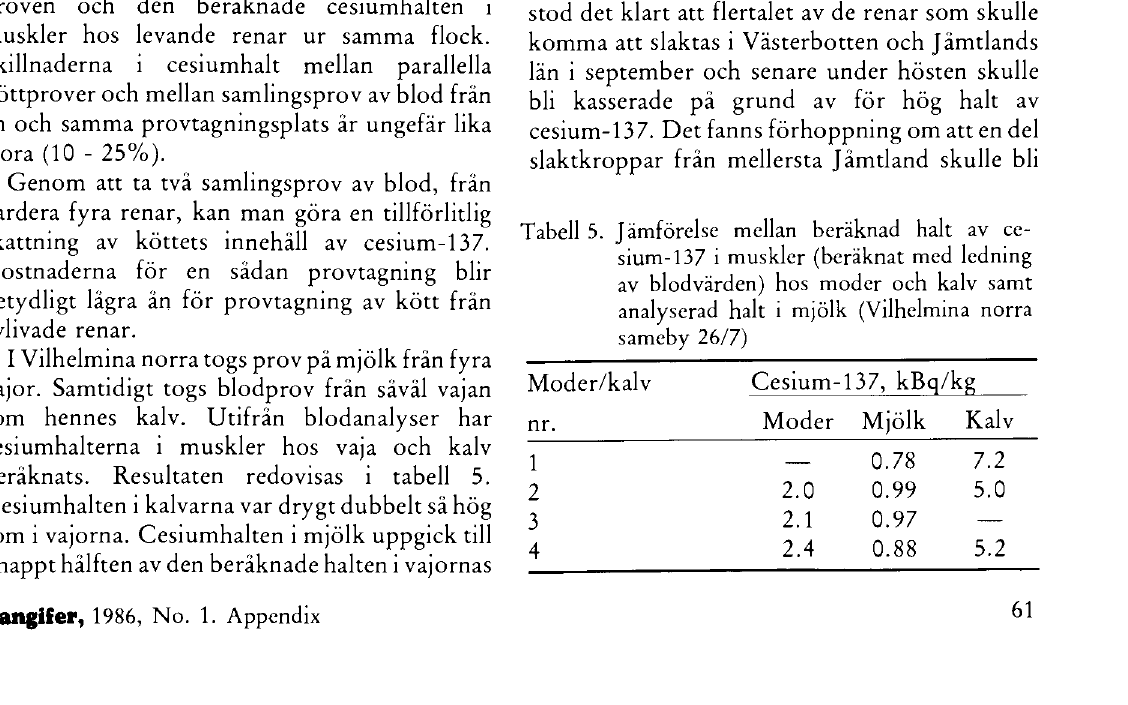
Tabell 5. Jåmforelse mellan beråknad halt av ce sium-137 i muskler (beråknat med